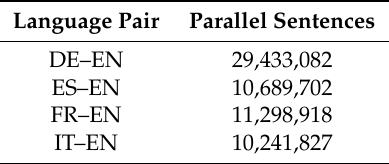
Table 1. Training data sizes for each language